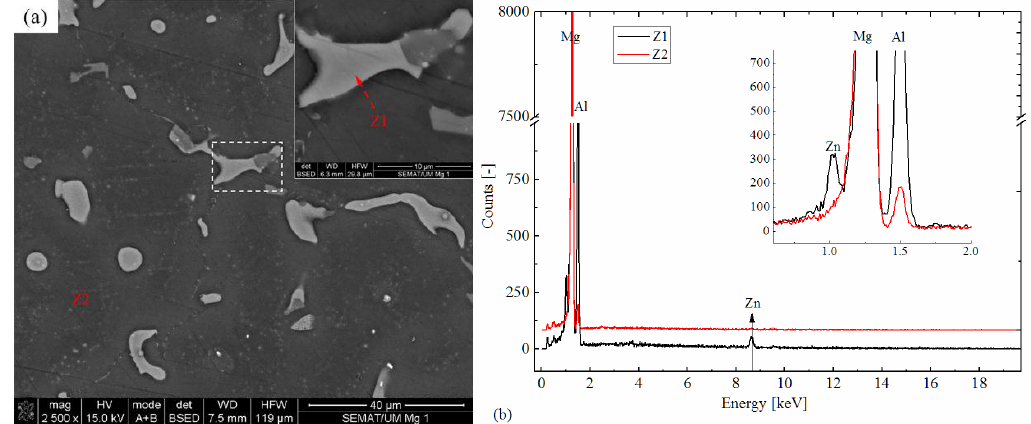
Figure 3. ( a ) Morphology and distribution of the β-Mg 17 Al 12 intermetallic phase in non-treated samples; and ( b ) EDS spectrum of the β-Mg 17 Al 12 intermetallic